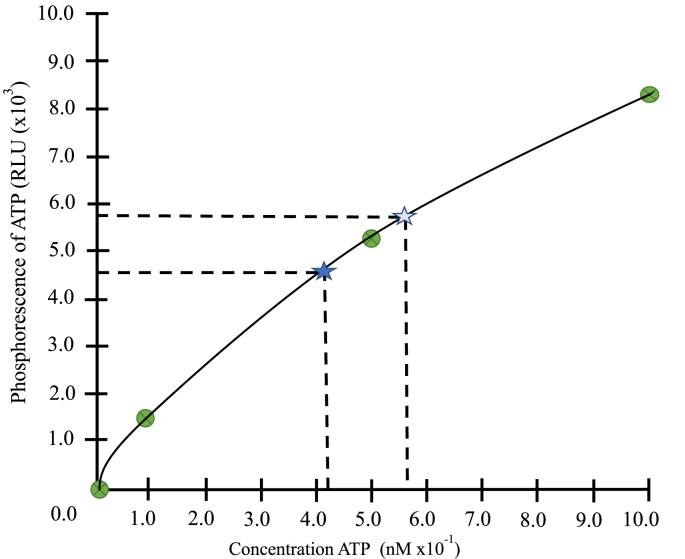
Phosphorescence of ATP in RLUs for known concentrations of ATP.RLU = Relative Light Units.Image 1 = 0 nM, 0.1 nM, 0.5 nM, 1 nM ATP.Image 2 = mean 4,569.Image 3 = mean 5,849.